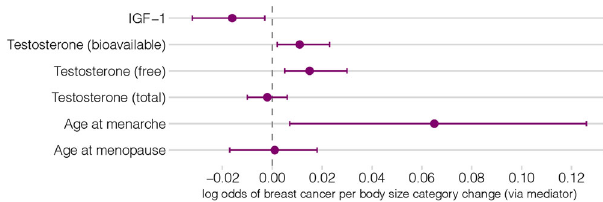
Fig. 5 Mediation analysis results: indirect effect of childhood body size on breast cancer via a mediator. The indirect effect was estimated as the product of coef fi cients of the total effect of exposure on the mediator (step 1 of two-step MR) and the direct effect of a mediator on the outcome (MVMR), i.e., Product method, and the 95% CIs were calculated based on SE estimated using Delta method. The presented data is available in Supplementary Data 18. The details about the datasets are provided in Fig. 4 Multivariable Mendelian randomization results of childhood body